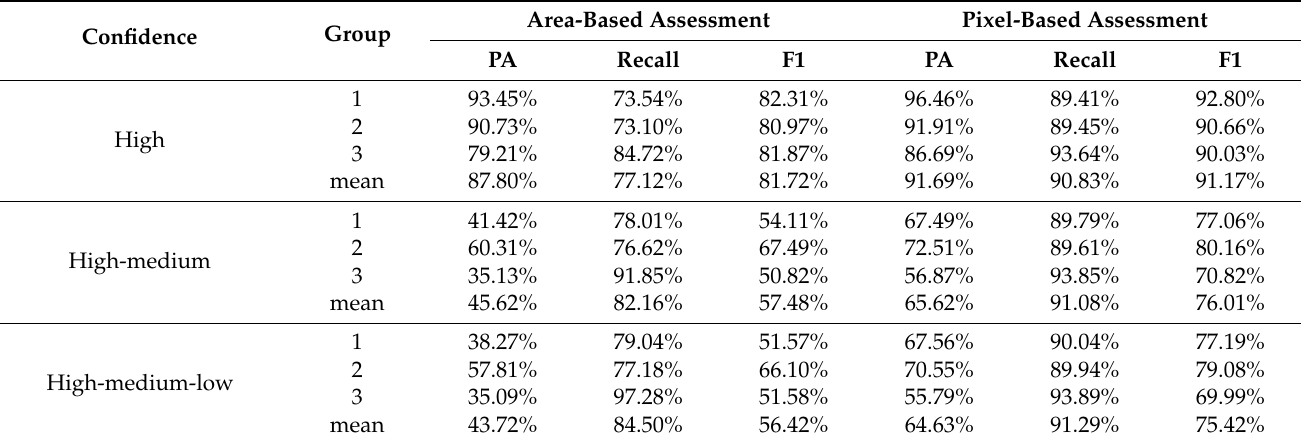
Table 2. Results of accuracy assessment. PA stands for Pixel